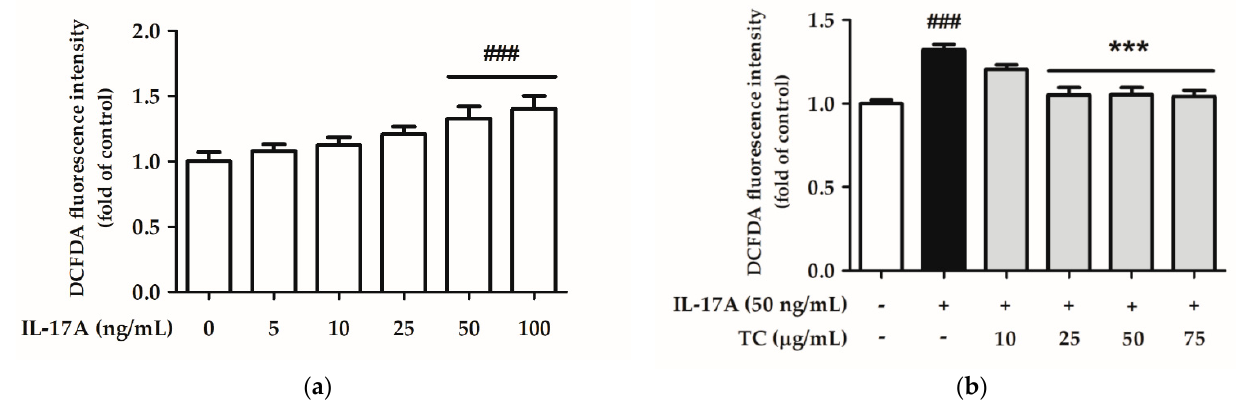
Figure 7. ( a ) IL-17A-induced and ( b ) TC inhibits IL-17A-induced intracellular oxidative stress in human keratinocytes. IL-17A at a concentration of 50 and 100 ng/mL significantly induced ROS generation, and TC suppressed IL-17A-induced ROS production in a dose-dependent manner in human keratinocytes. Significant differences between treated groups were evaluated. ### p < 0.001 compared to the control group. *** p < 0.001 compared to the IL-17A-induced group.